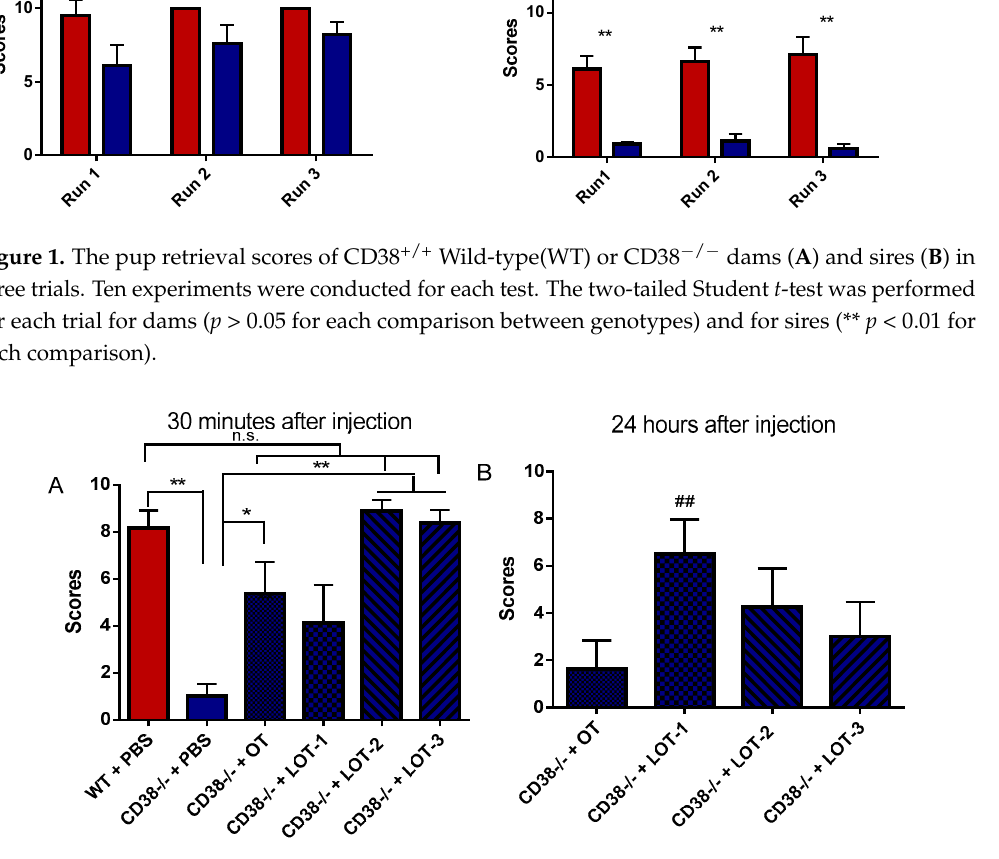
Figure 2. Pup retrieval behavior by the sires. The parental scores for CD38 +/+ Wild-type (WT) or CD38 − / − sires at 30 min ( A ) and 24 h ( B ) after a single i.p. injection of Phosphate Buffered Saline (PBS), Oxytocin (OT), or the Lipo-oxytocins (LOTs) (100 ng/100 g of body weight); n = 8–10 for each test. One-way ANOVA followed by Bonferroni’s post hoc test was performed for 30 min ( F 5,52 = 13.32, p = 0.0001) and 24 h ( F 4,40 = 3.42 p = 0.017). Bonferroni post hoc test compared with CD38 − / − treated by PBS revealed significance at * p < 0.05 and ** p < 0.01; n.s. not significant. ## p < 0.01 for CD38 − / − mice treated with OT.